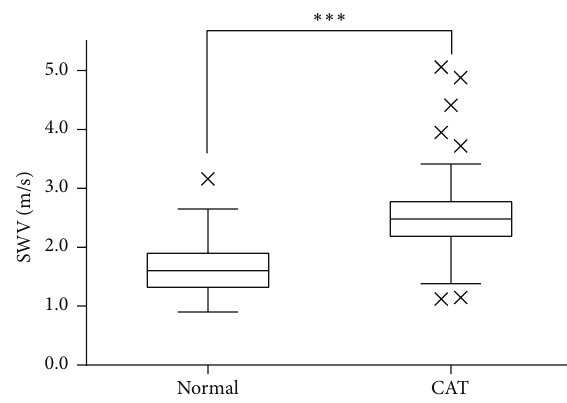
Figure 2: Box-and-whisker plots showing the shear wave velocity in each group. The symbol × indicates an outlier. ∗∗∗ 𝑃 < 0.001 .